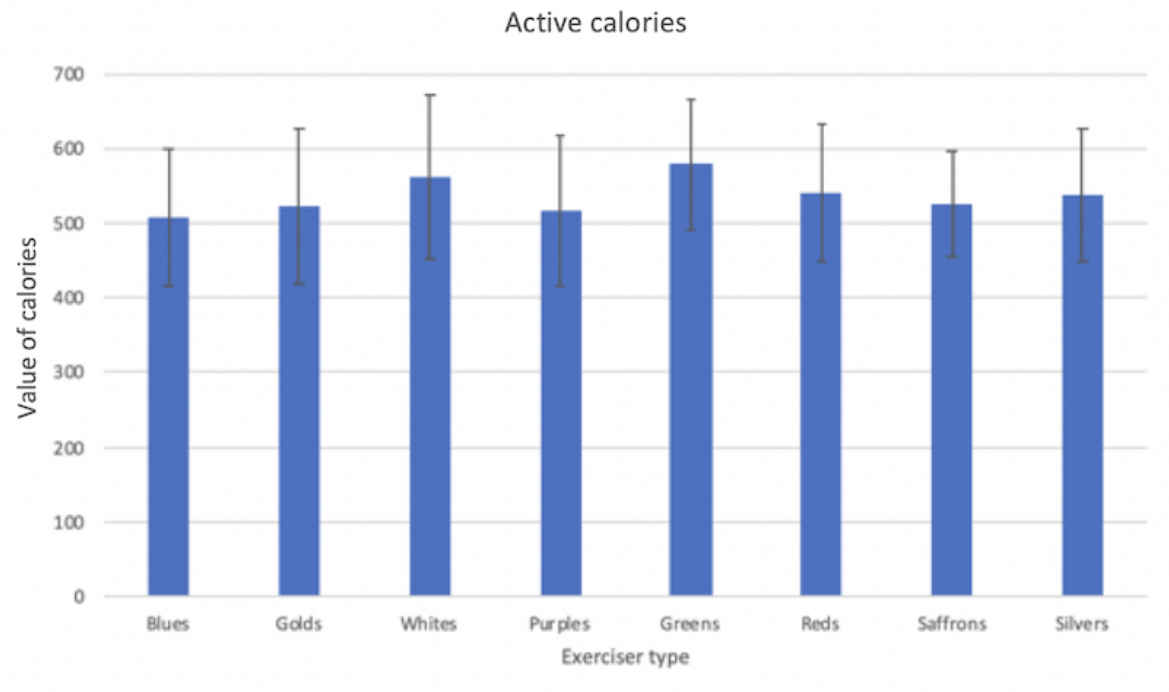
Figure 12. Average active calories for different exerciser types.